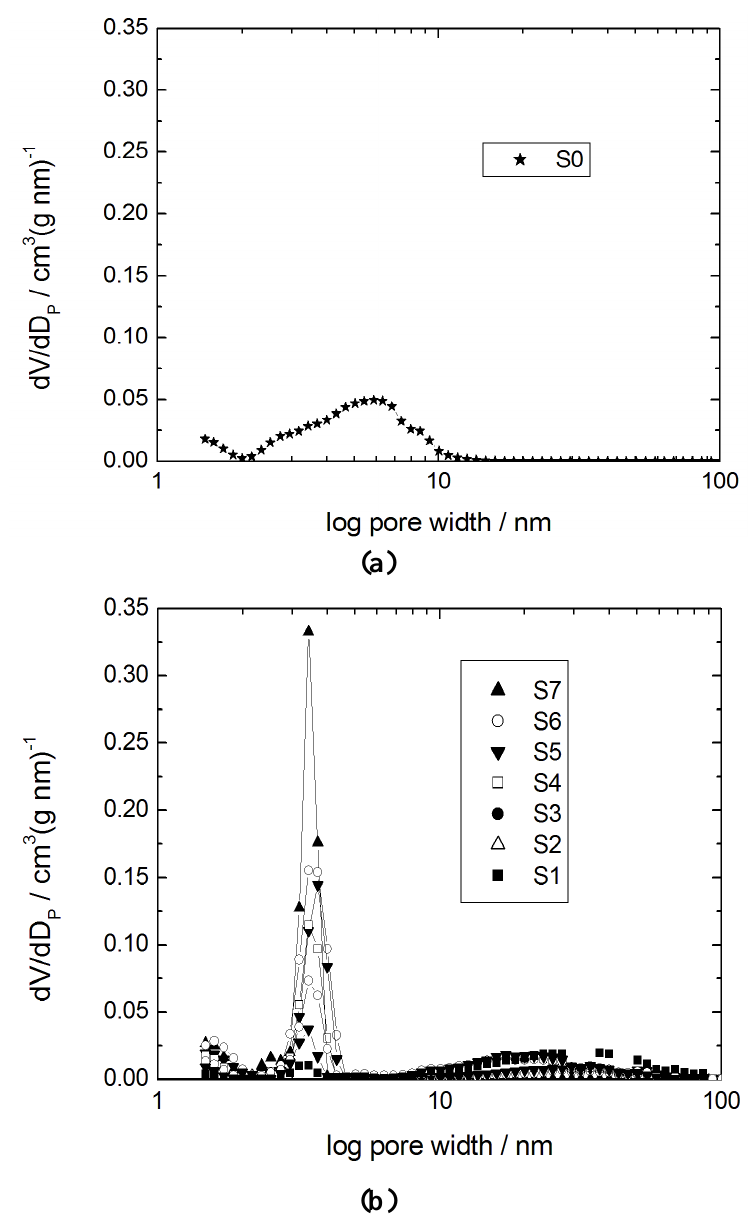
Figure 2. Pore width distributions calculated using the density functional theory (DFT) model (slit pore) for ( a ) the initial silica gel S0; and ( b ) the transformation products